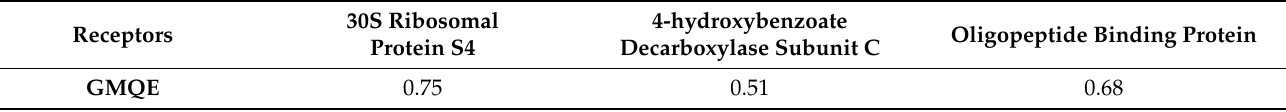
Table 2. Depicting the quality and the refinement of the predicted structure using different computa- tional